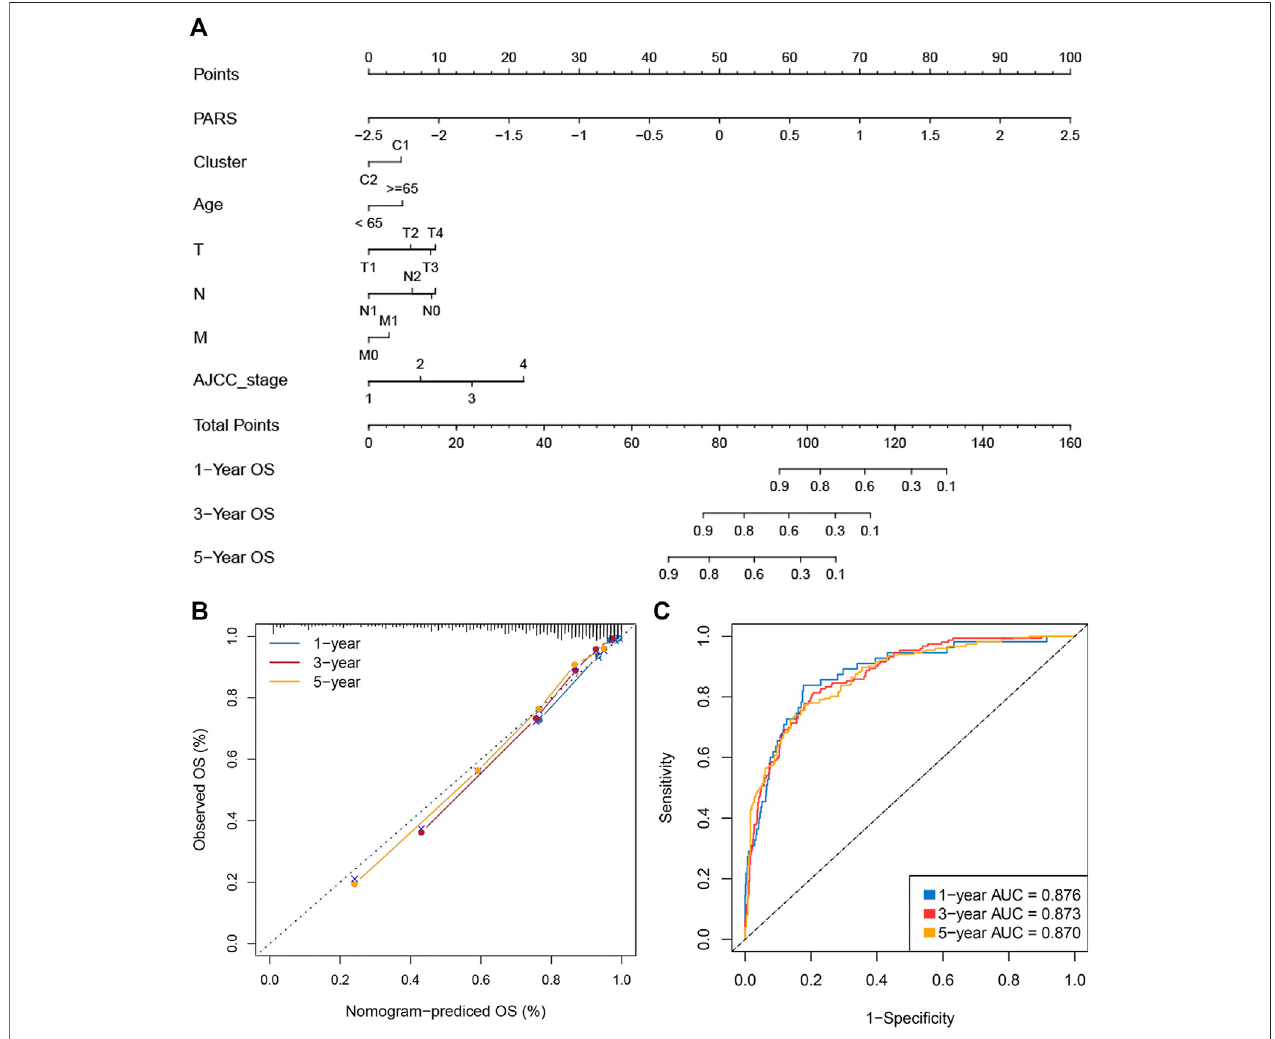
FIGURE7| Constructionofanomogramforevaluatingprognosis. (A) Nomogramforpredictingthe1-,3-,and5 yearsOSofCRCpatients. (B) Calibrationanalysis of our nomogram in evaluating the 1-, 3-, and 5years OS. (C) . ROC curve for evaluating the performance of nomogram in predicting the 1-, 3-, and 5 years OS.